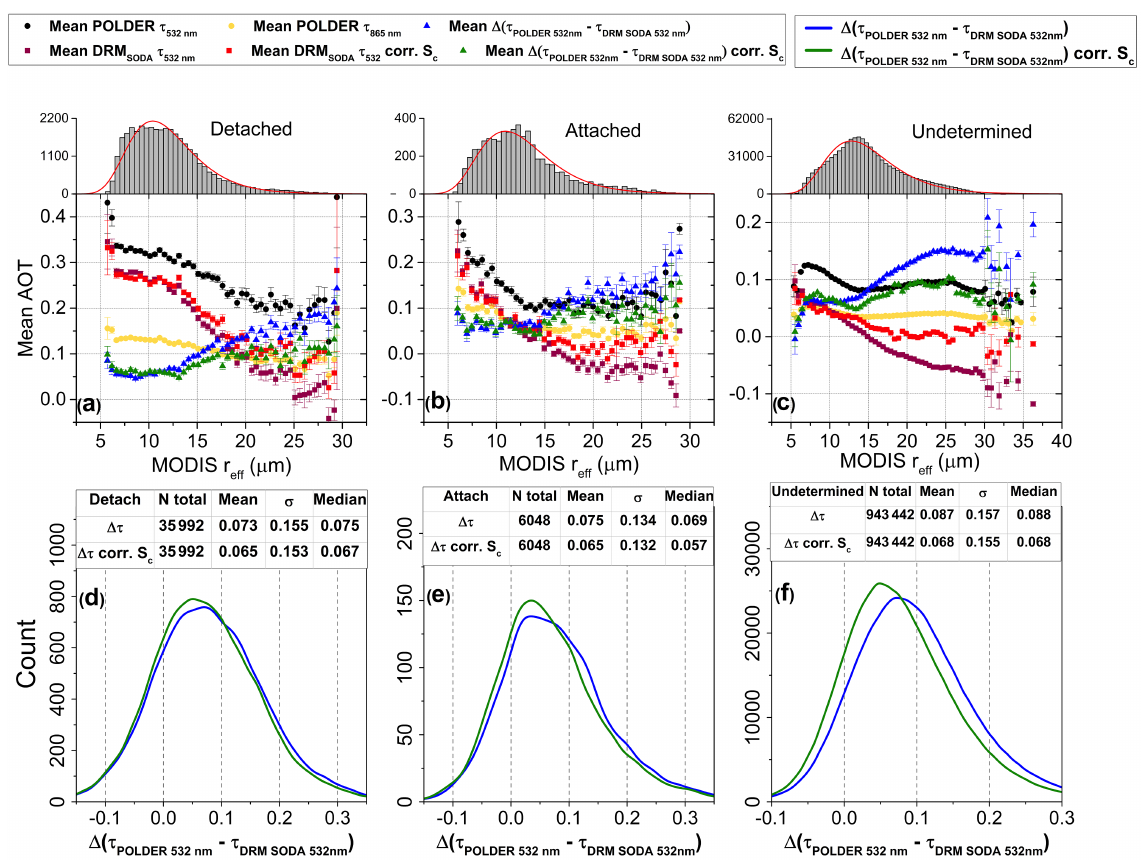
Figure 6. Four and a half years of global study on the evolution of POLDER and DRM SODA above-cloud AOT retrievals as a function of MODIS effective radius ( r eff , µm) for situations where the aerosol layer is detached from the cloud top (a, d) , for cases where the aerosol layer is attached to the cloud top (b, e) and for undetermined situations (c, f) . The histograms in (a) – (c) represent the distribution of r eff . The histograms in (d) – (f) present the difference between POLDER and DRM SODA mean AOTs, before the correction of DRM SODA AOT with r eff ( (cid:49)τ) and after this correction ( (cid:49)τ corr. S c ) . The associated tables indicate the number of cases, mean, standard deviation ( σ) and median values of these differences. The error bars in (a) – (c) represent the standard error of the mean